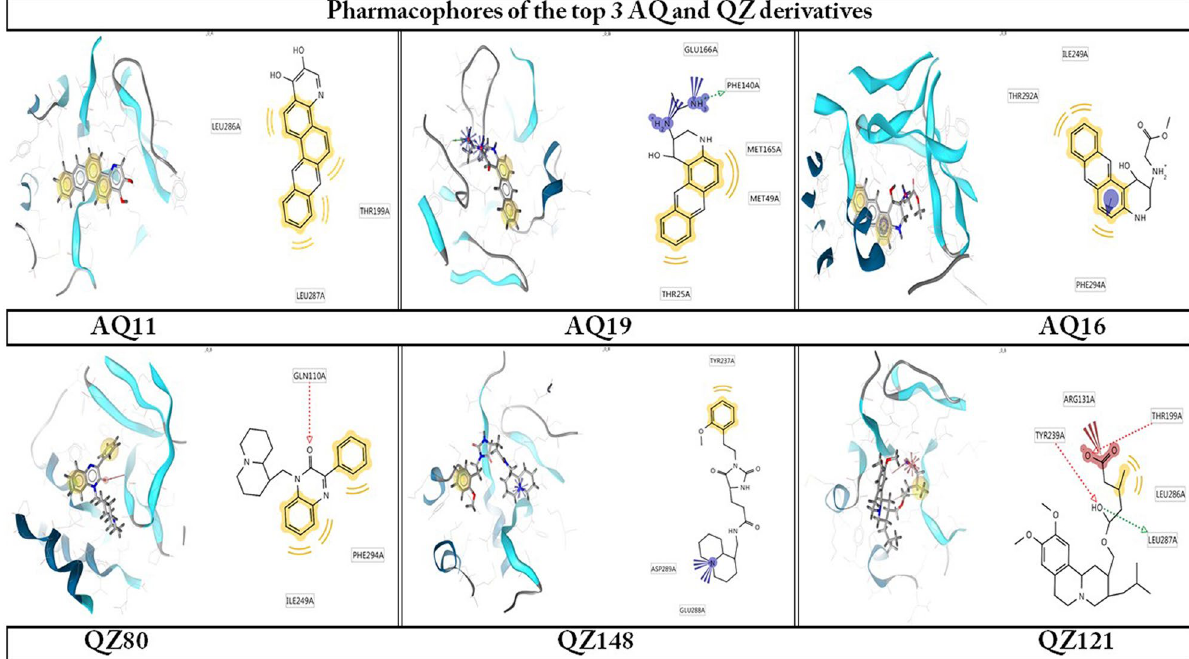
Figure 3. The 3D and 2D structure build pharmacophore models of top 3 AQ and QZ derivatives interacting with Mpro protein(Yellow spheres indicating the hydrophobic interactions, Red coloured arrows indicating H-bond acceptors, Green coloured arrows indicating H-bond and blue stars like indicating the positive ionisable groups.